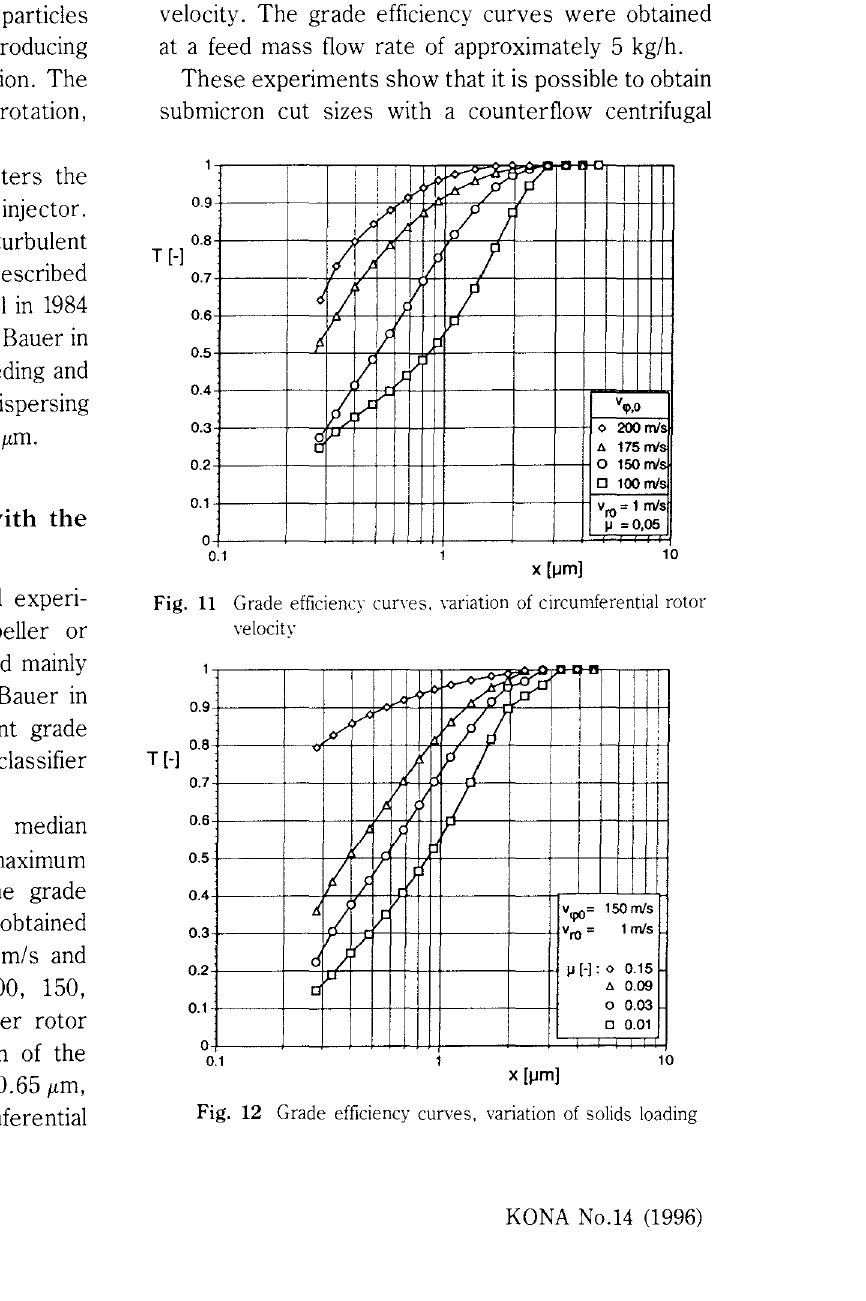
Fig. 12 Grade efficiency curves. Yariation of solids loading